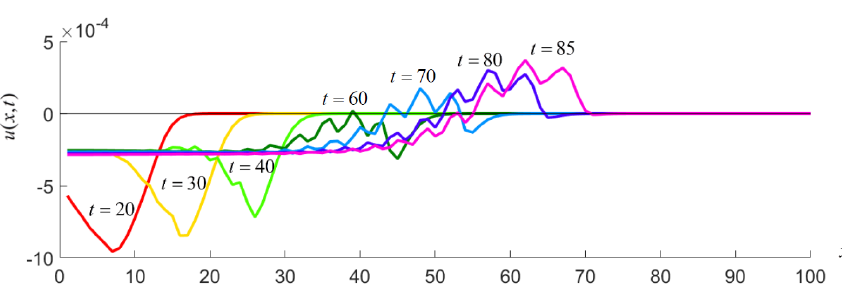
Figure 3. Displacement u(x,t) at different time moments versus the horizontal coordinate x for the tension–compression harmonic